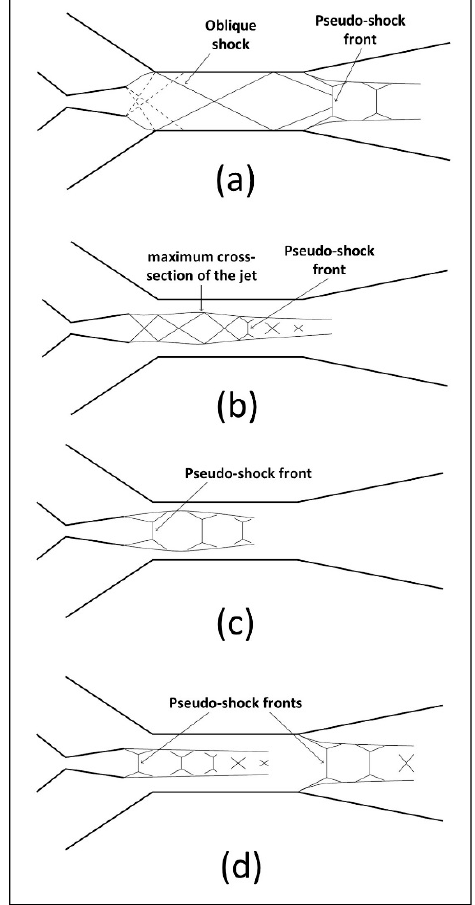
Figure 17. Internal ejector flow structure: ( a ) fully developed supersonic flow; ( b ) supersonic flow with secondary sonic throat; ( c ) supersonic saturated regime; ( d ) supersonic regime with double choking [107].